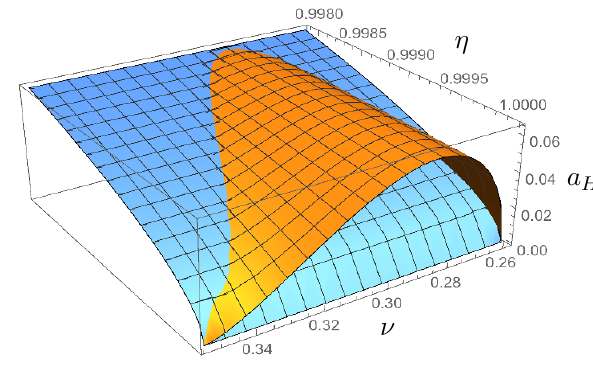
p p p 2 (cid:0) 3 < (cid:23) < 1 = (2 2) and 0 : 998 < (cid:17) < 1. The blue surface is 2